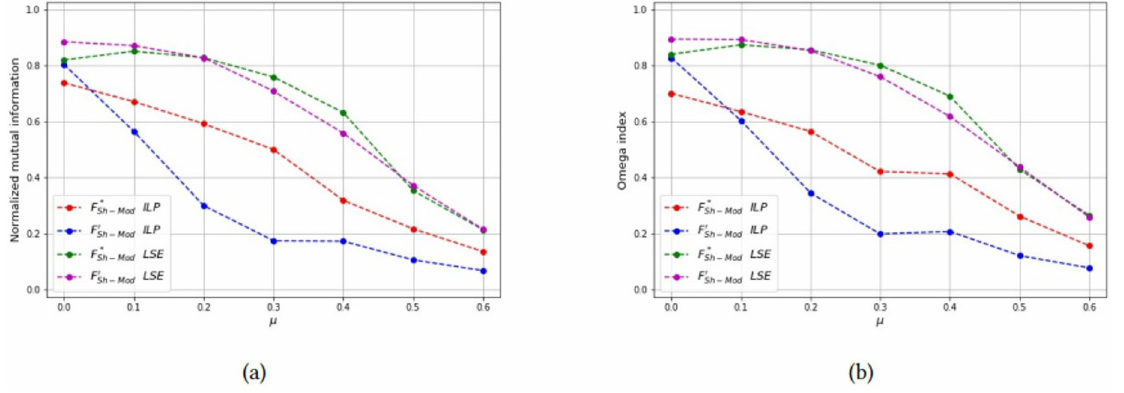
Fig 19. Test results on overlapping communities, parameters p = 3, μ o = 0.7, N o = 3. (a) Average NMI for each solution method, (b) Average Omega for each solution method.